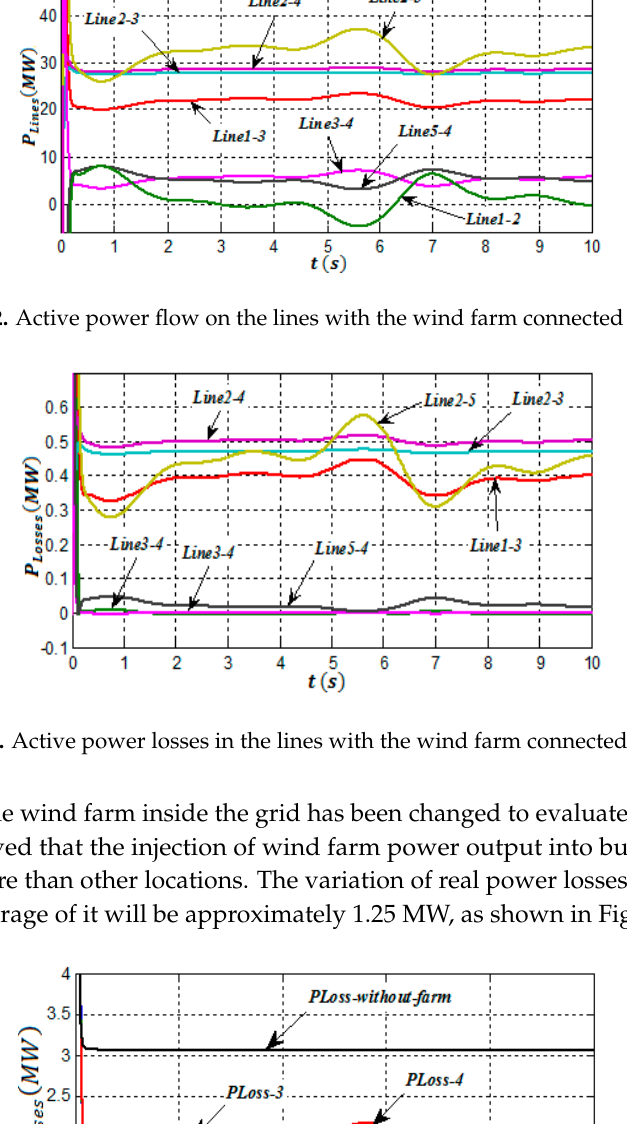
Figure 11. Active power losses in the lines before the integration of the wind farm.